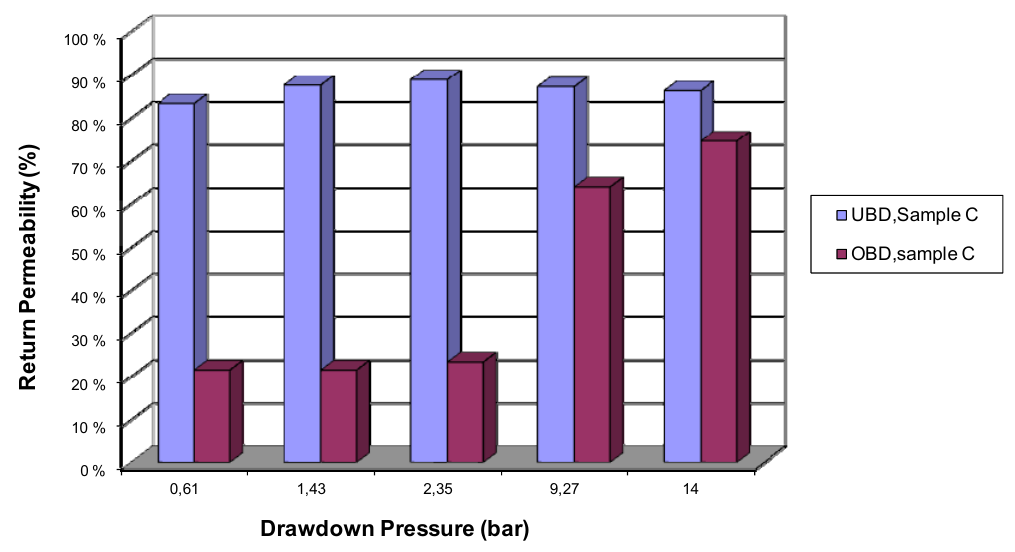
Figure 5. Permeability & Drawdown in post UBD and OBP-sample